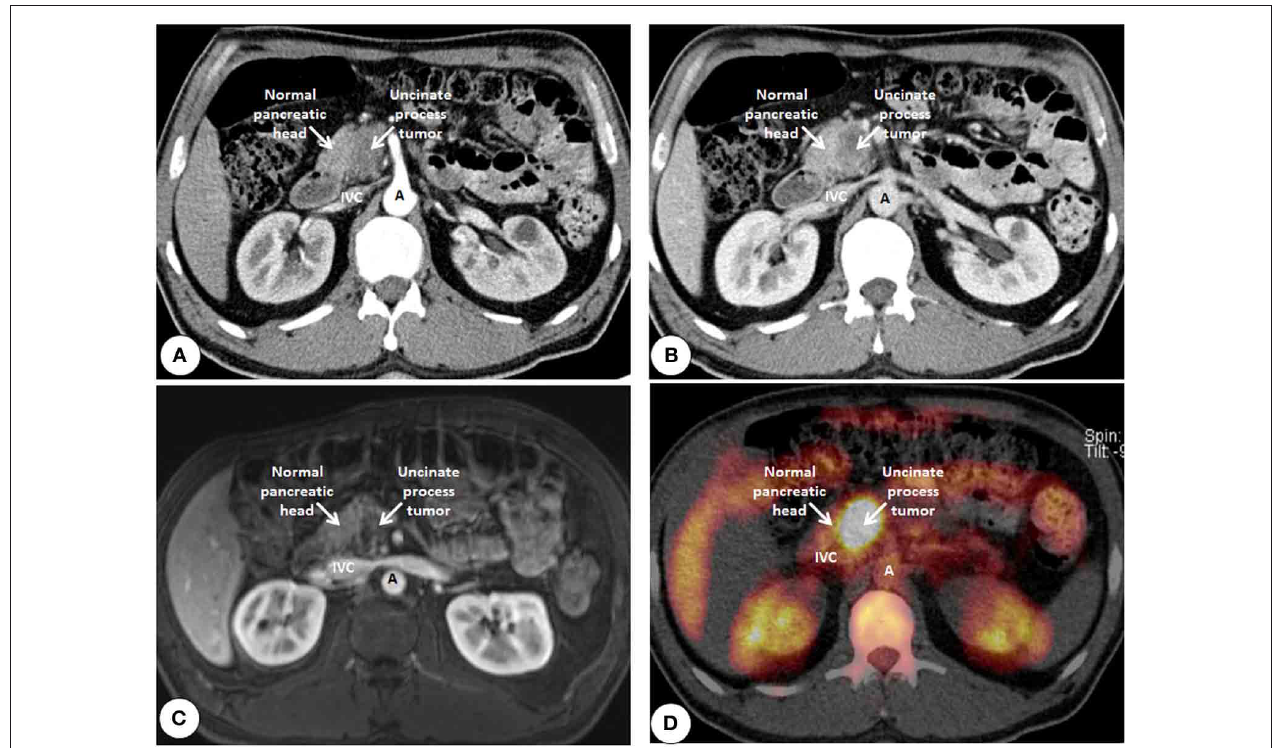
FIGURE 7 | Crosssectional imaging ofan uncinateprocessductal adenocarcinoma usingtoolsof conventionalradiology.(A) Computed tomography using intravenous contrast enhancement (arterial phase) shows the delayed contrast uptake of the fibrotic tumor (darker) compared to the normal pancreas (lighter). (B) Data acquisition during the venous phase shows an increase of contrast difference due to the reduced perfusion of the fibrotic